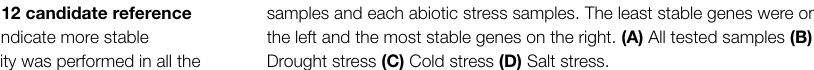
FIGURE 2 | Expression stability values (M) of 12 candidate reference genes calculated by geNorm. LowerM values indicate more stable expression. Ranking of the gene expression stability was performed in all the